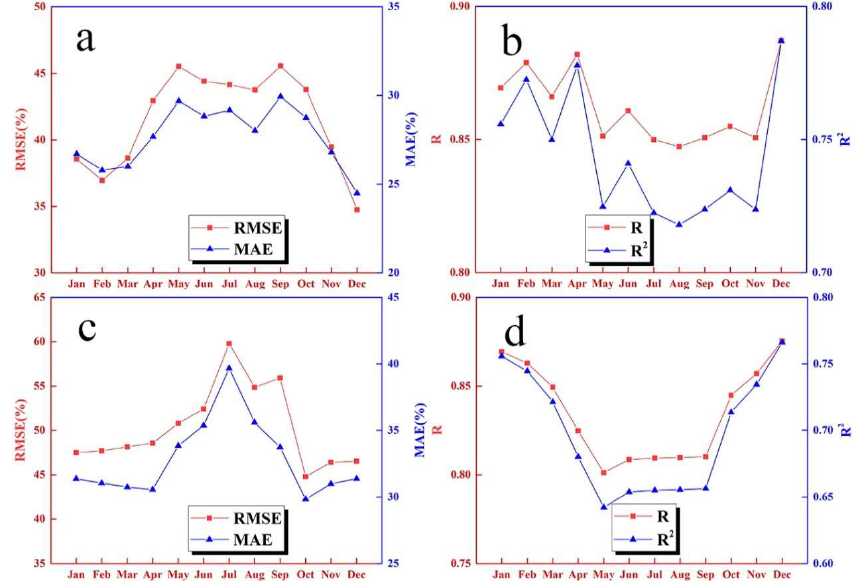
Figure 7. Monthly variation of the statistical indicators representing the model accuracy for the estimated AOD values at the CARSNET and AERONET stations: ( a , b ) CARSNET stations; and( c , d ) AERONET stations)during 2002–2014.